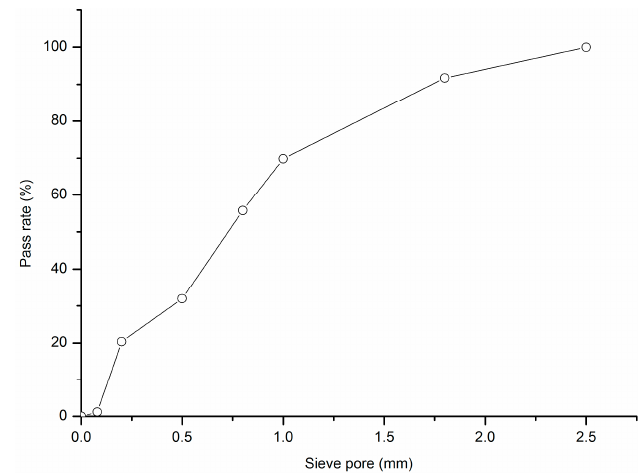
Figure 7. Aggregate grading curve.